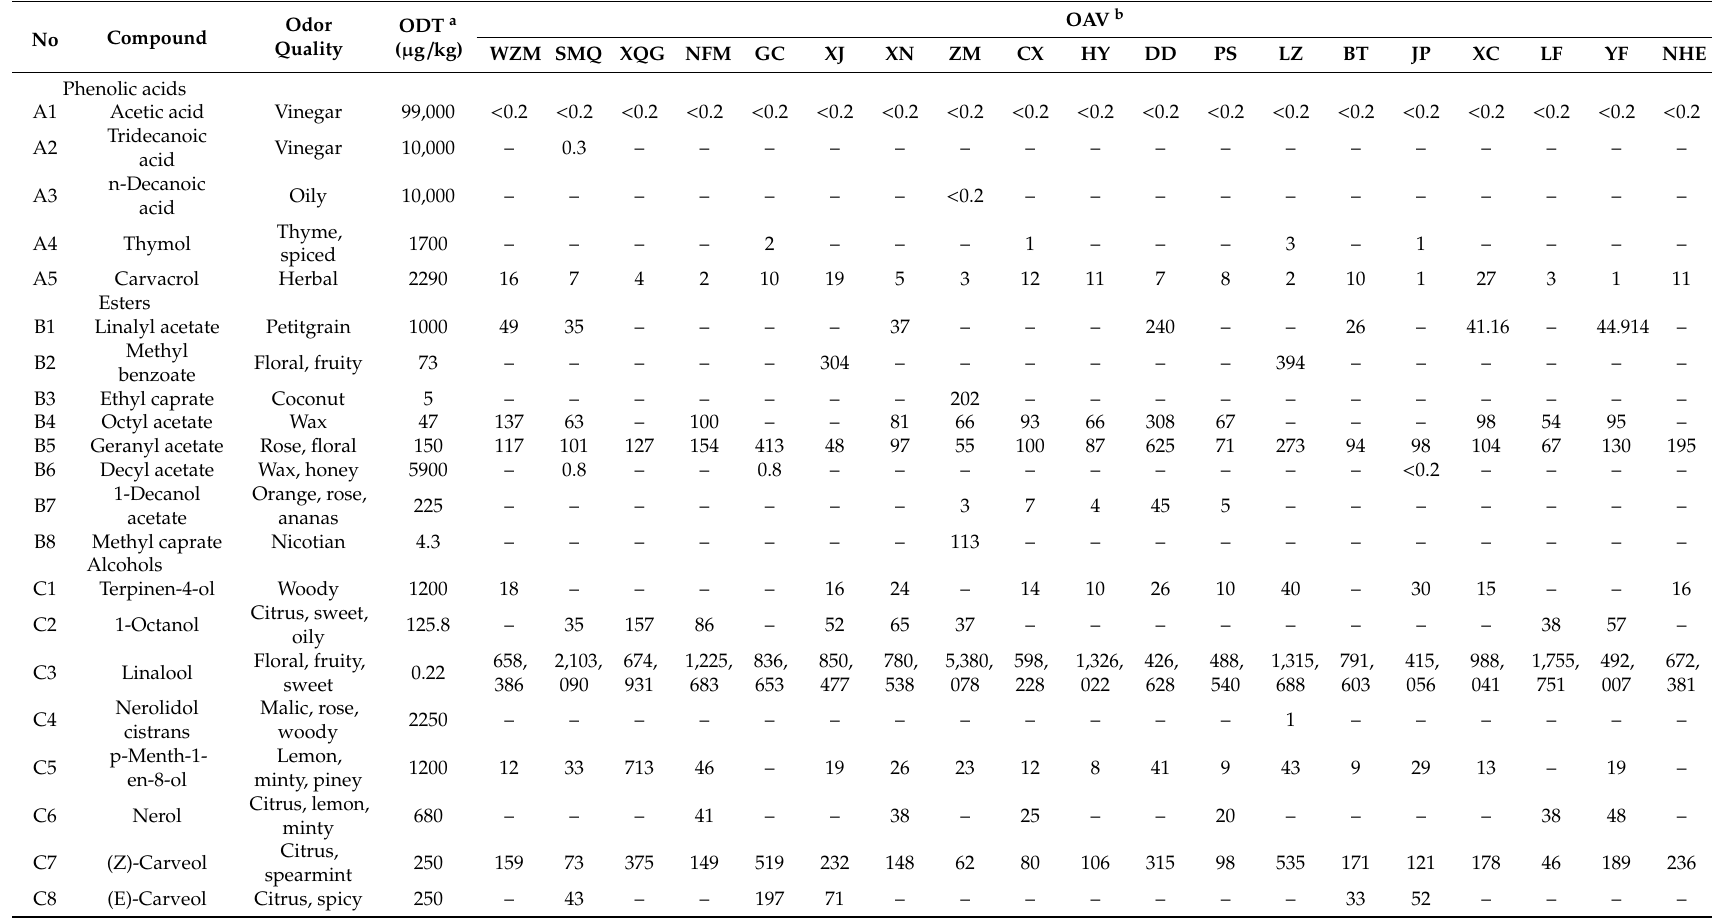
Table 1. Odor detection thresholds (ODT) and odor activity values (OAV) of major odor active compounds in citrus-tea as detected by headspace solid-phase microextraction-gas chromatography-mass spectrometry